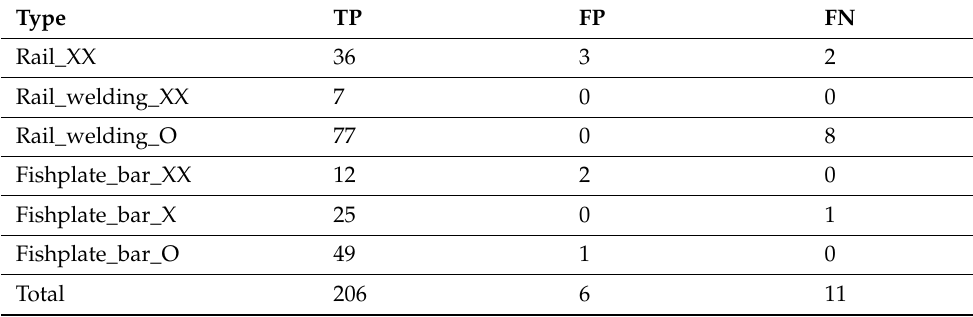
Table 11. YOLOv4 training results for each defective type in the side view.